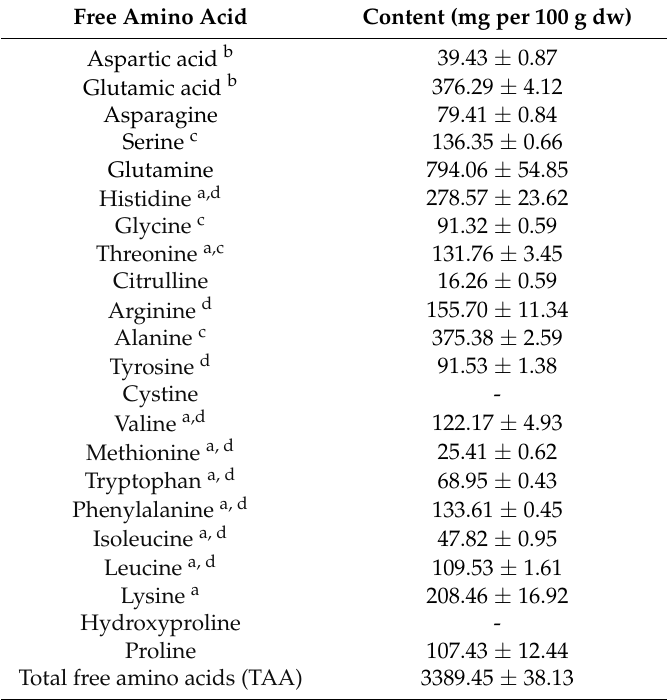
Table 3. Free amino acids composition of wild L. deliciosus .